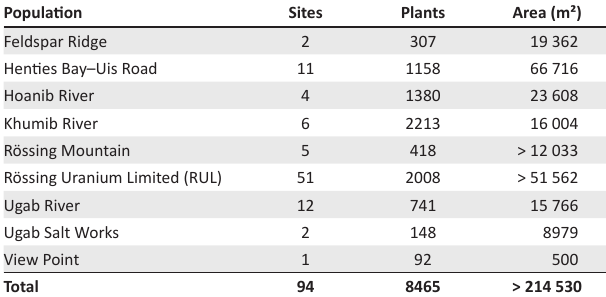
FIGURE 2: Distribution of surveyed Lithops ruschiorum populations. 1. View Point, 2. Khumib River, 3. Hoanib River, 4. Ugab River, 5. Ugab Salt Works, 6. Henties Bay–Uis Road, 7. Rössing Mountain, 8. Feldspar Ridge, 9. Rössing Uranium Limited (RUL) license area, 10. Henties Bay–Usakos Road. Circle size is roughly proportional to number of plants observed in each population. Populations used for collecting demographic data: black circle, populations used for collecting seed: grey circle, populations used for both purposes: unfilled circle. In addition, the total distributional area determined from all 21 recorded populations is shown (small green dots). TABLE 1: Investigated populations with number of sites, number of plants and occupied